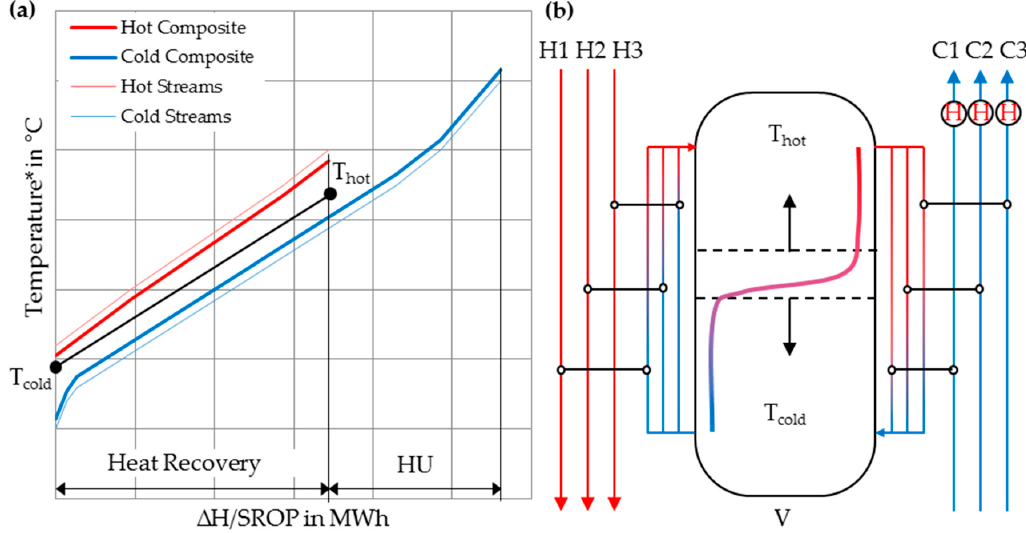
Figure 7. From ( a ) the indirect source and sink profile (ISSP) to ( b ) the HRL dimensioning.